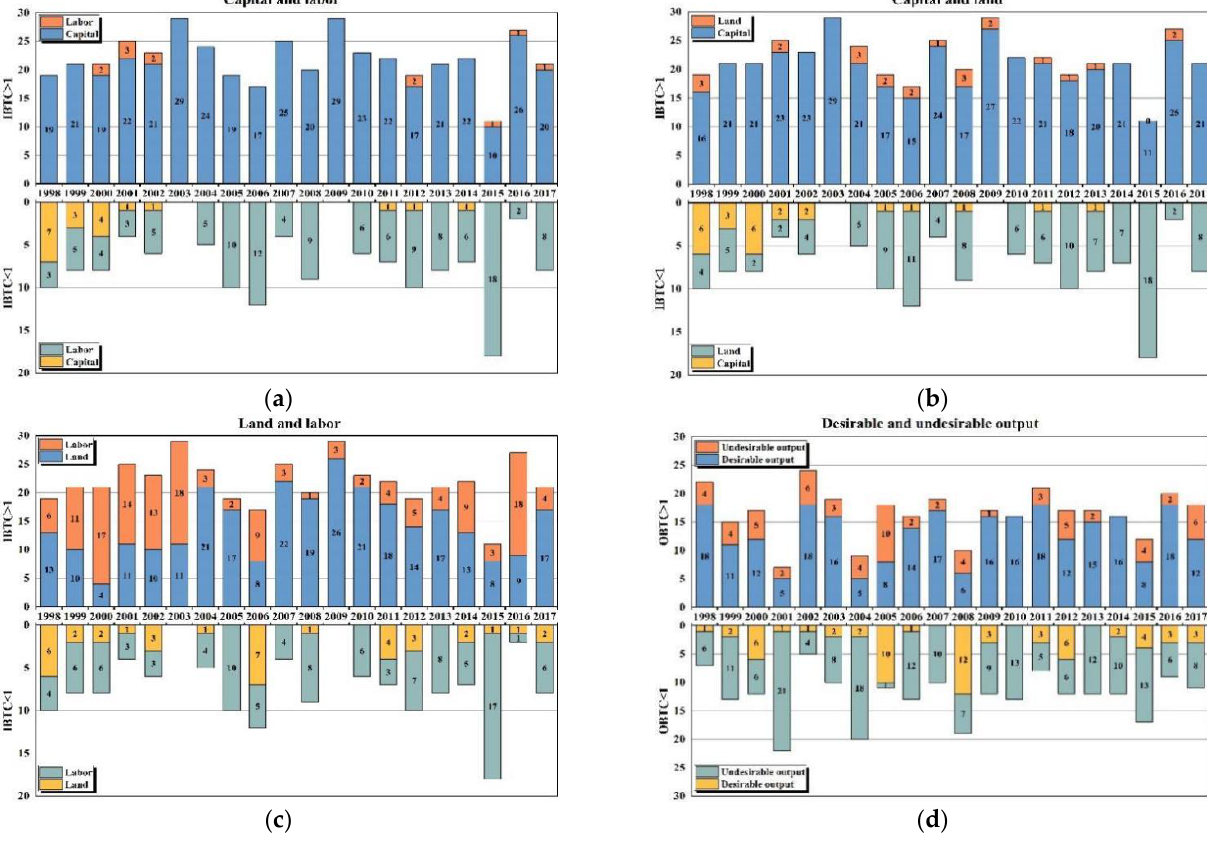
Figure 4. Statistics of input bias and output bias: ( a ) capital – labor combination; ( b ) capital – land combination; ( c ) land – labor combination; ( d ) desirable – undesirable combination.